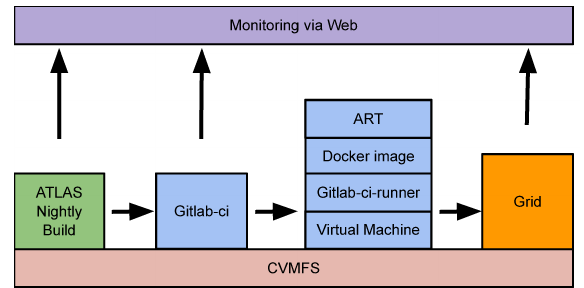
Figure 1. ART architecture for Grid